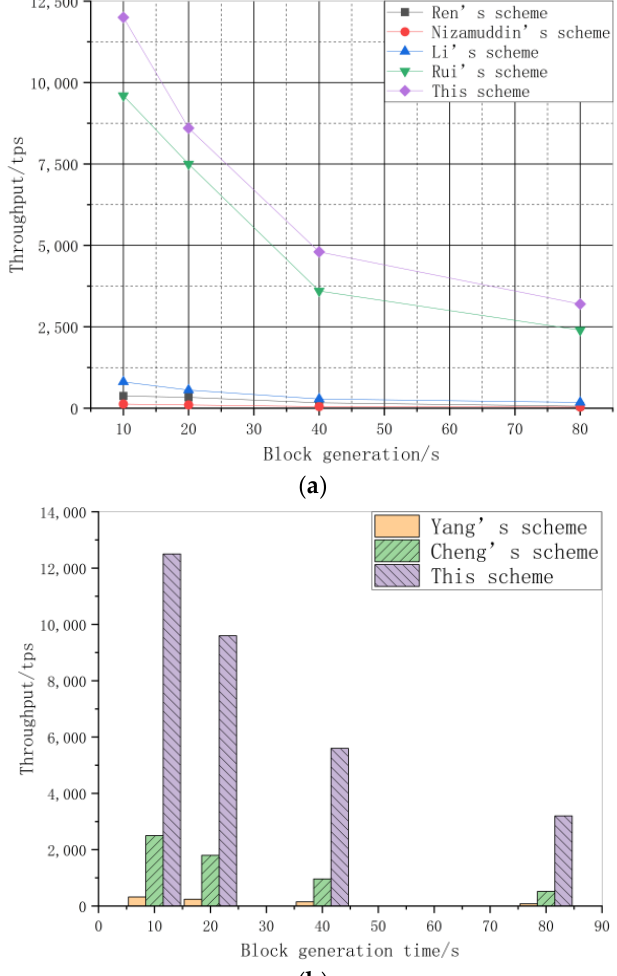
Figure 10. Experimental results of throughput: ( a ) Secure storage chain; ( b ) deletion verification chain.